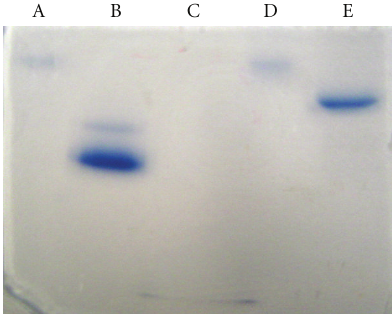
Figure 1: Basic and native protein gel electrophoresis of Cratylia mollis seed lectins and conjugates. (A) Cramoll 1,4-HRP, (B) Cramoll 1,4, (C) cytochrome C, (D) Cramoll 3-HRP, and (E) Cramoll